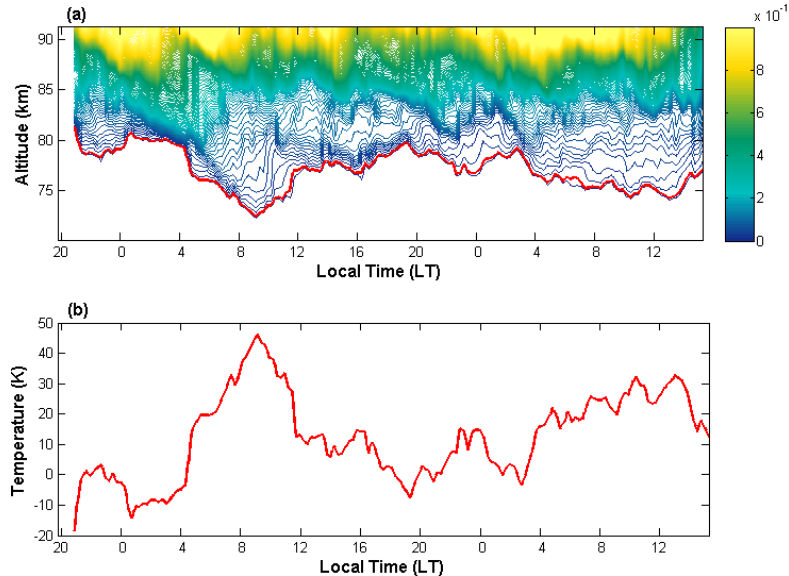
Figure 10. (a) Na mixing ratio corresponding to Fig. 2a; (b) adiabatic vertical motion-induced temperature perturbations calculated from the highlighted Na mixing ratio isopleth (1 × 10 − 12 ) in (a)